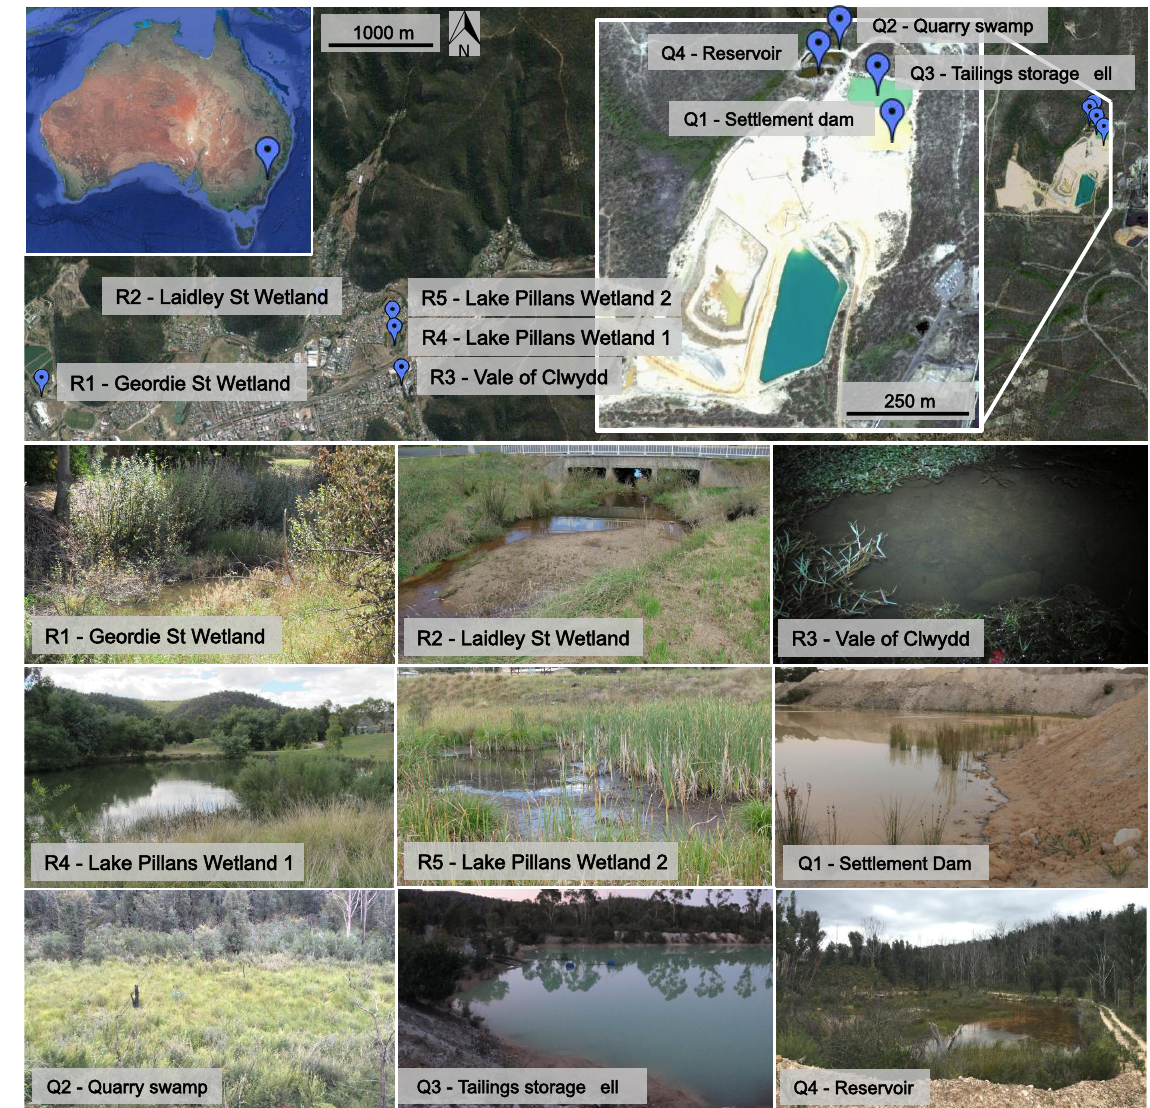
Figure 1. Map of the study area (the suburbs of Lithgow and Clarence, New South Wales, Australia), with the Kables Sands Quarry expanded inset, showing site locations, and photographs of the nine wetlands surveyed. Reference wetlands: R1 is Geordie St Wetland, R2 is Laidley St Wetland, and R3 is Vale of Clwydd Wetland, R4 is Lake Pillans Wetland 1, and R5 is Lake Pillans Wetland. Quarry wetlands: Q1 is settlement dam, Q2 is quarry swamp, Q3 is tailings storage cell and Q4 is reservoir. Satellite image credit: Google